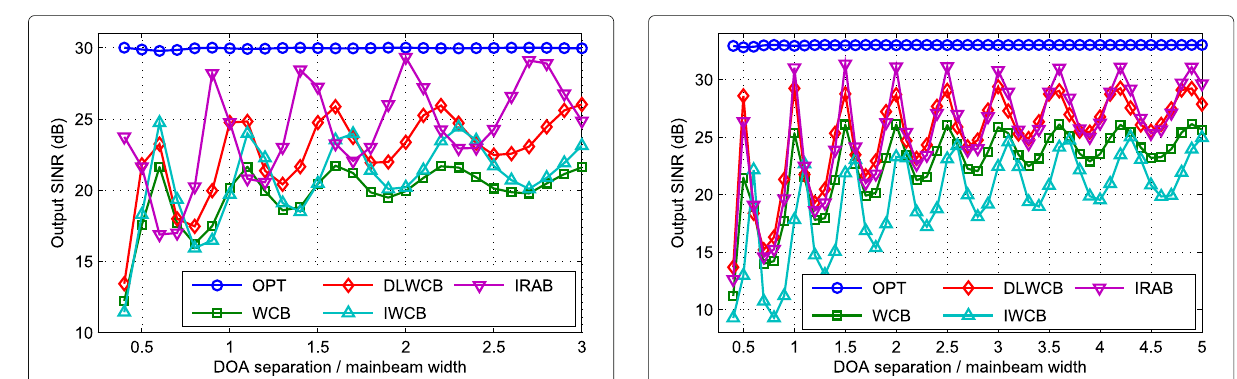
12 ◦ , respectively (calculated by conventional beamformer with weight vector equals to the steering vector of desired signal). The SNR of desired signal is 20 dB. There is only one interference with INR=15 dB. The DOA separation between desired signal and interference varies from 0.4 to 5 times of main beam width. Other parameters are the same with the parameters declared in the beginning of Section 4.